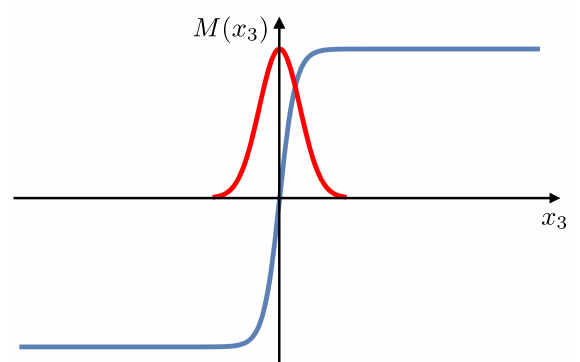
) (blue line) at the boundary of a topological Figure 19: Mass profile M = M ( x 3 insulator and wavefunction of the Dirac zero mode (red